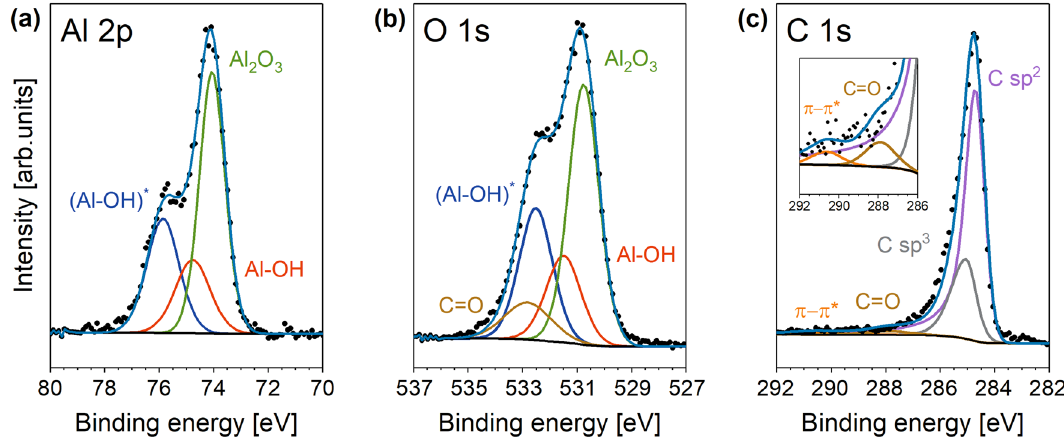
Figure 2. Core-level spectra of SLG on H 2 -etched sapphire for a take-off angle of 45° and a pass energy of 11.75 eV: ( a , b ) show the Al 2p and O 1s spectra, which are essentially related to the sapphire surface; ( c ) shows the C 1s spectrum originating from the graphene layer and adsorbed carbon species; inset shows magnification. The black dots show the raw data, the steel blue lines show the envelopes of the fitted components, and the black lines show the subtracted Shirley backgrounds. The following components are used for the fit: (Al–OH)* in blue, Al–OH in red, Al 2 O 3 in green, C=O in brown, π–π* in orange, C sp 3 in grey and C sp 2 in violet. Details are summarized in Table